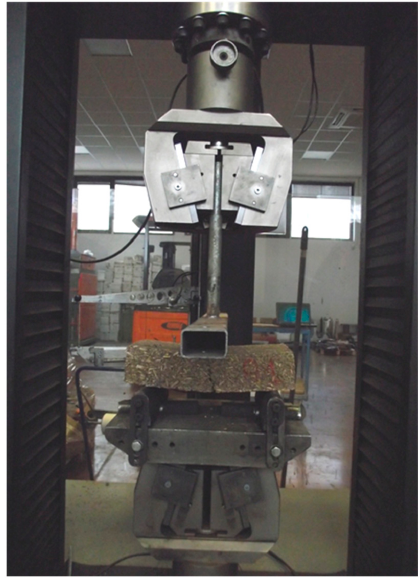
Figure 7. Setup of flexural tests.